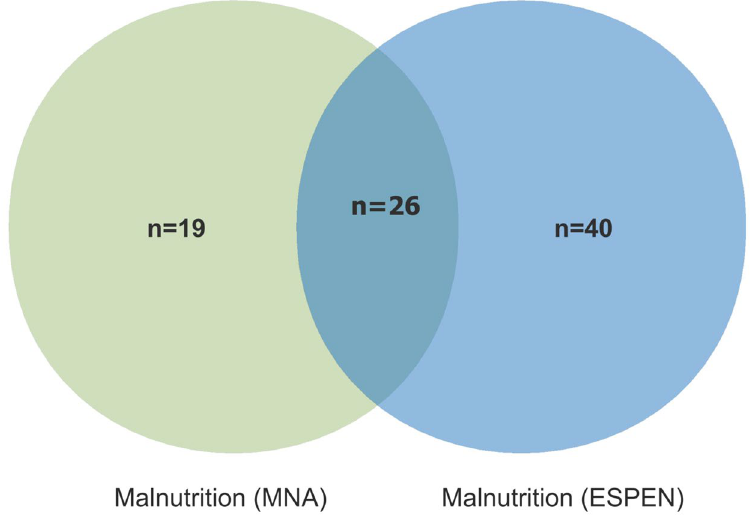
Figure 2. Venn diagram illustrating the overlap between malnutrition MNA and malnutrition ESPEN .